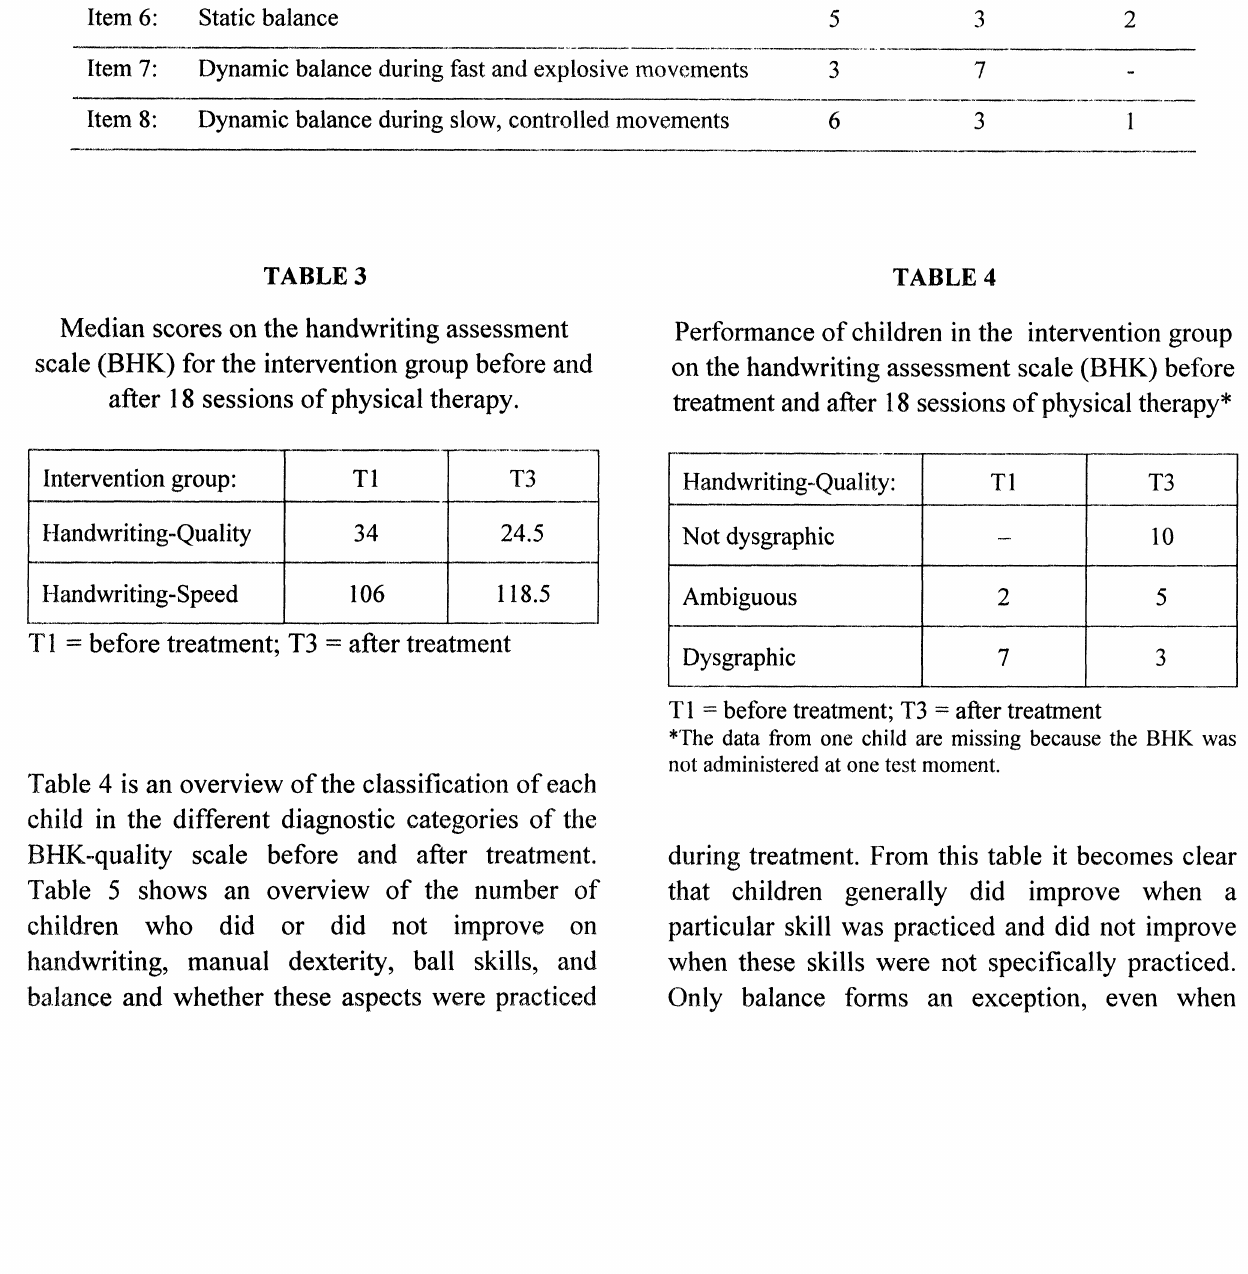
Performance of children in each item of the Movement-ABC items of the Movement ABC Number of children